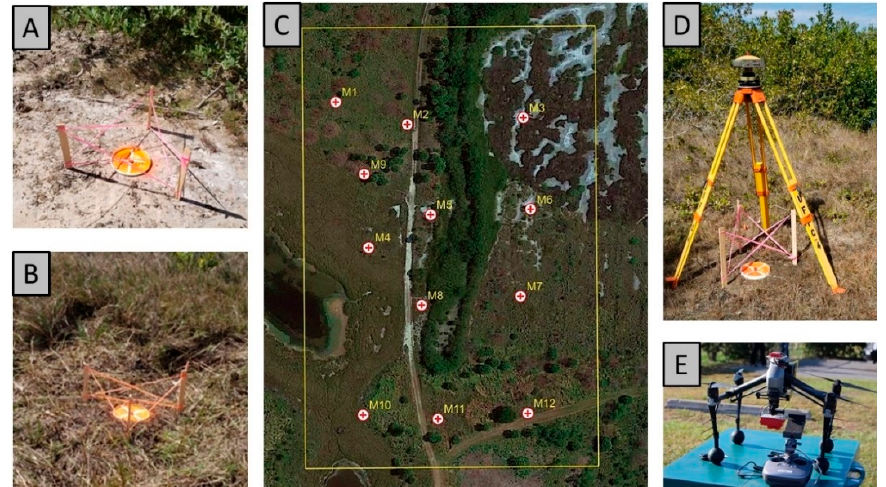
Figure 6. Study area preparation and data collection ( A , B ) Ground control points close up views, ( C ) Ground control points distribution within the study area, enumerated from M1 to M12, ( D ) GNSS survey, receiver occupying a ground control point, ( E ) Micasense RedEdge-MX sensor mounted on the “Inspire 2” UAS.